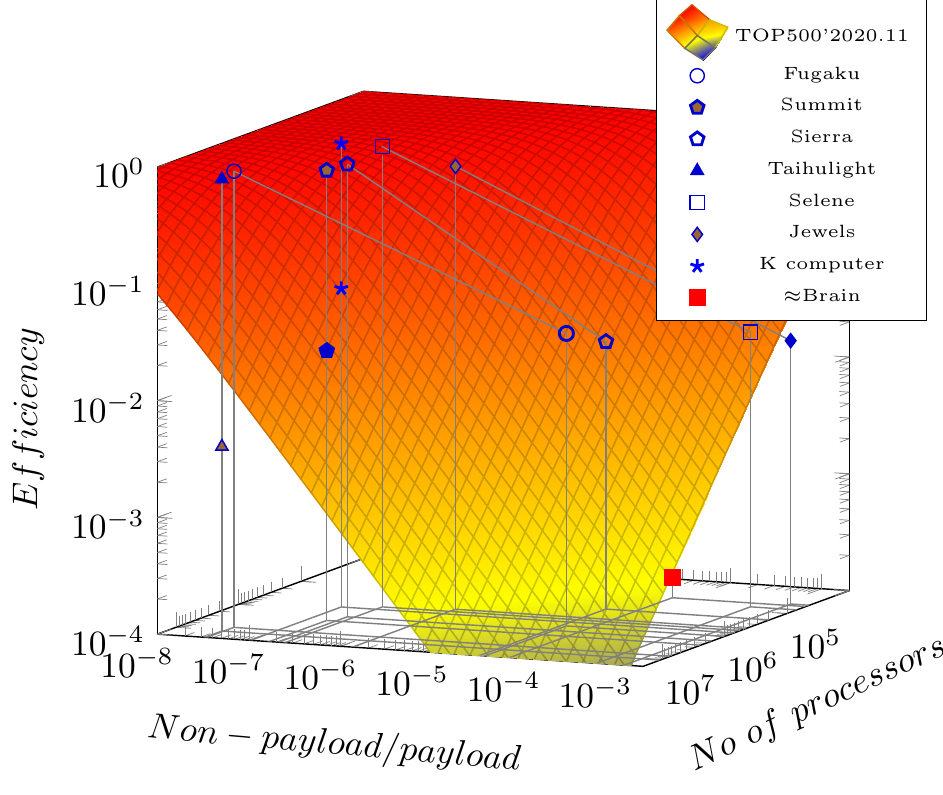
Figure 8. The two-parameter efficiency surface (in function of the parallelization efficiency measured by benchmark HPL and the number of the PUs) as concluded from Amdahl’s Law (see [42]), in the first order approximation. Some sample efficiency values for some selected supercomputers are shown, measured with benchmarks High Performance Linpack (HPL) and High Performance Conjugate Gradients (HPCG), respectively. Moreover, the estimated efficacy of brain simulation using conventional computing is